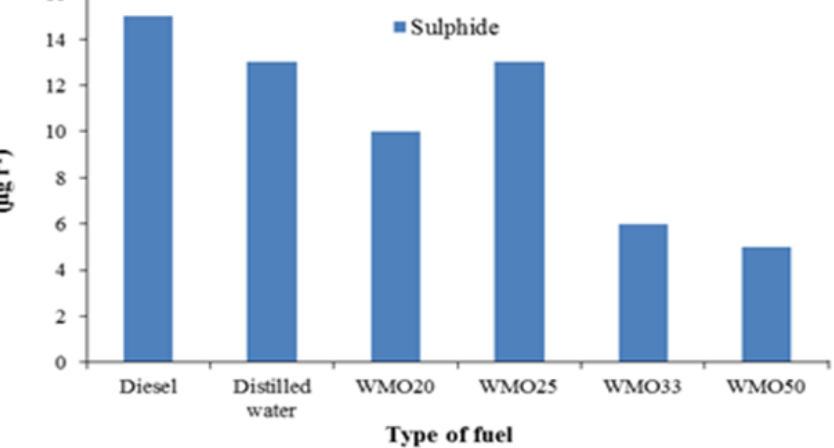
Figure 8. pH variations in the solution during the flue gas purification for different fuel types.